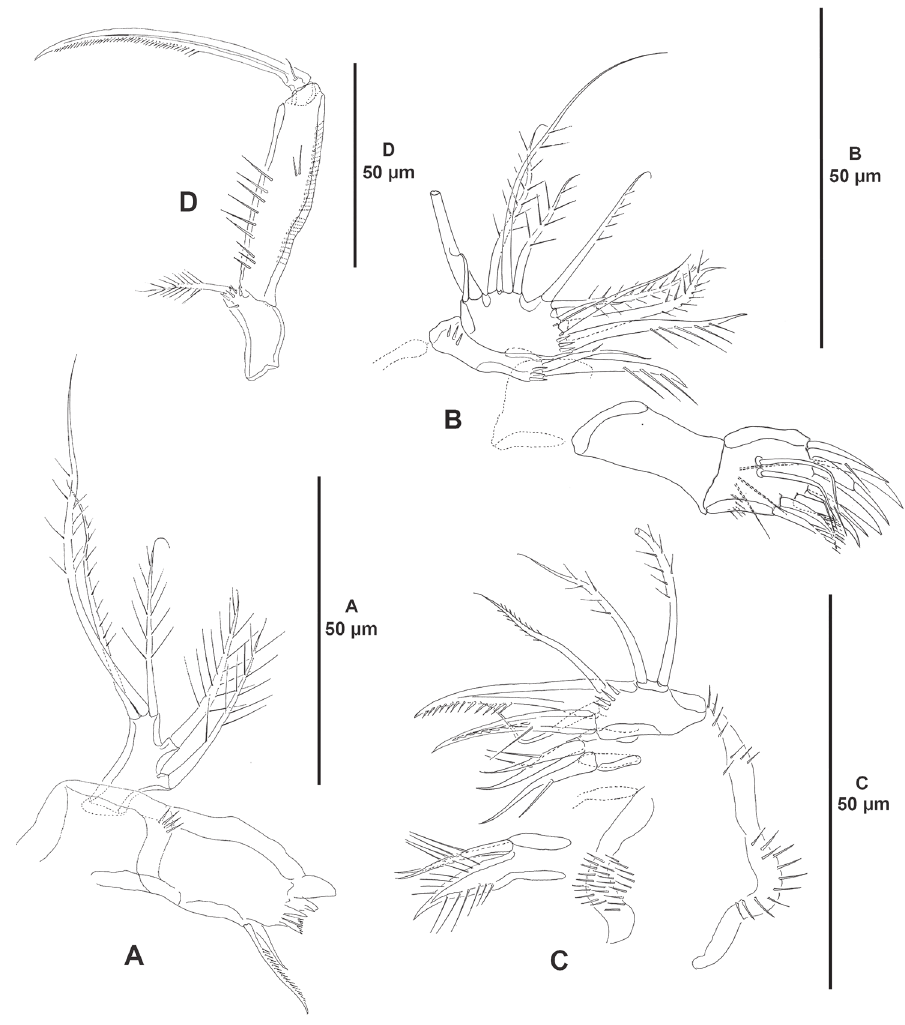
Figure 5. Ceratonotus elongatus sp. n., female holotype. A mandible B maxillule C maxilla, showing insertion of proximal endite D